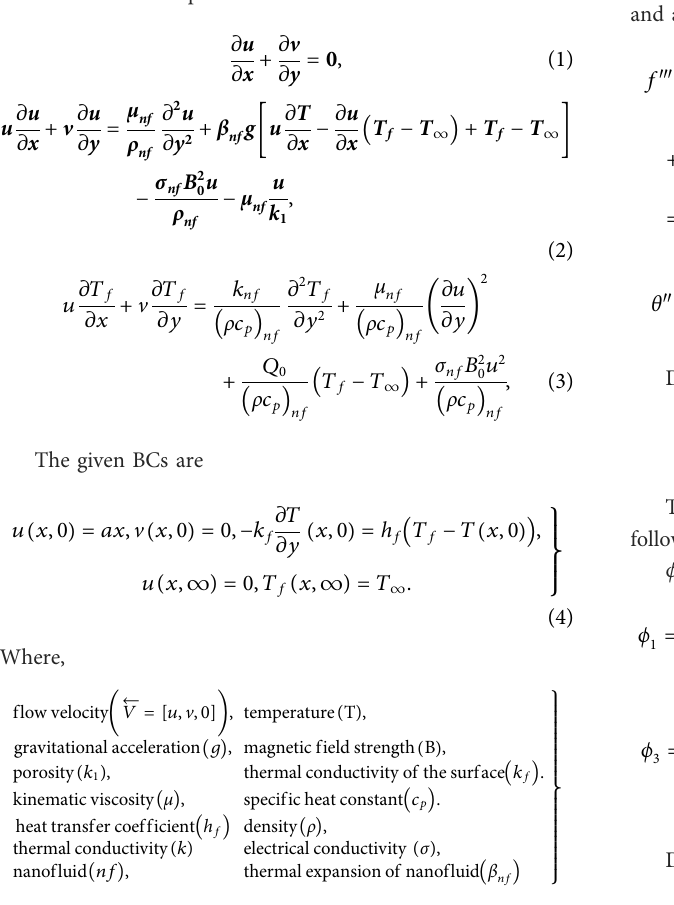
Table 1 below lists nanoparticle correlations. Equations 1 – 4 become dimensionless by adding new variables.